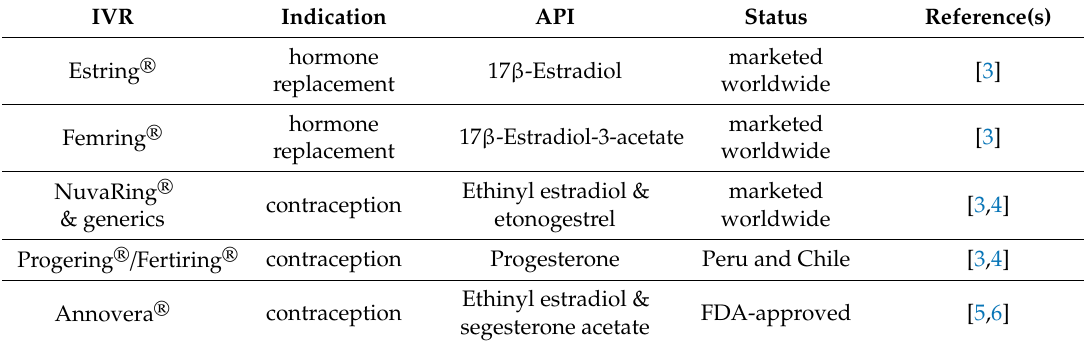
Table 1. Currently marketed intravaginal ring formulations